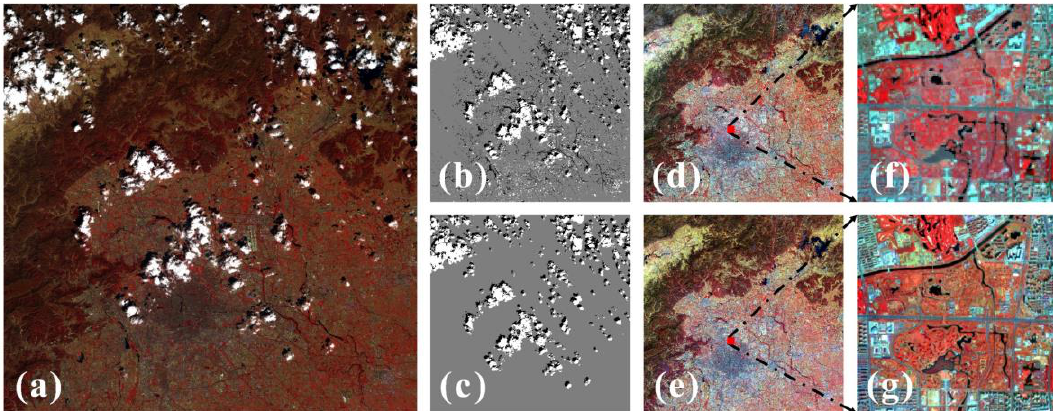
Figure 2. Steps of data preprocessing to generate fused 10 m time series and urban extent boundary.